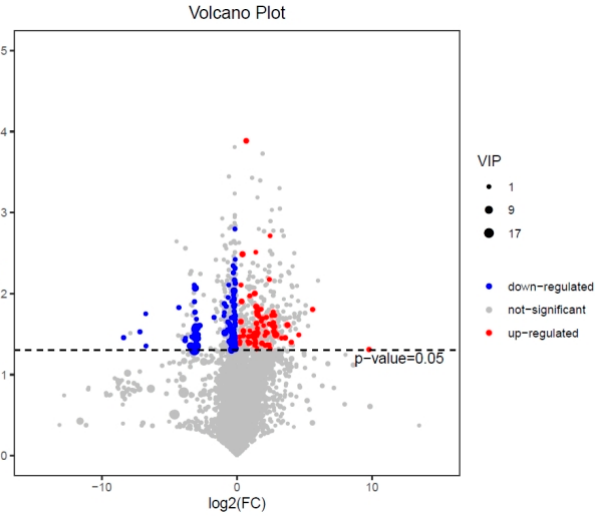
Figure 6. Volcano plot of differential metabolite screening in the 24-h 0.5 A~24-h CK group. Hierarchical clustering was performed on the differential metabolites and a heat map was drawn to better visualize the data (Figure 7).